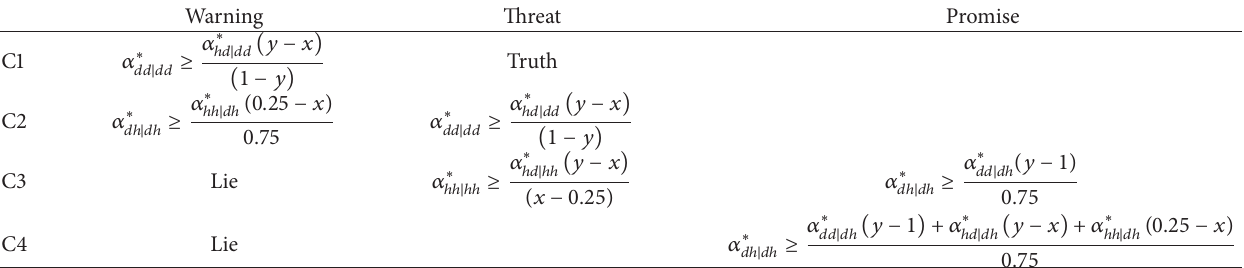
Table 7: Beliefs that support the perfect Bayesian